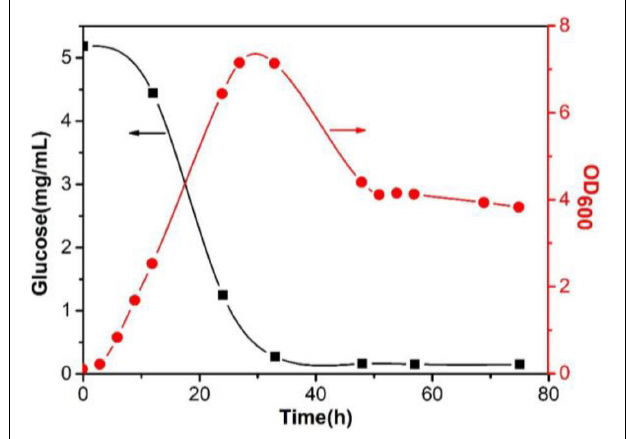
FIGURE 7 | Glucose content change in the fermentation medium and the growth curve of Sphingomonas sp.